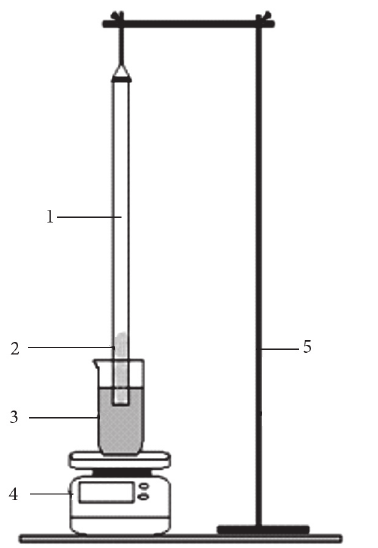
Fig. 1. Scheme of the device used to measure imbibition capacity: 1 – polypropylene stripe; 2 – imbibed emulsion; 3 – beaker with the investigated emulsion; 4 – analytical balance; 5 –